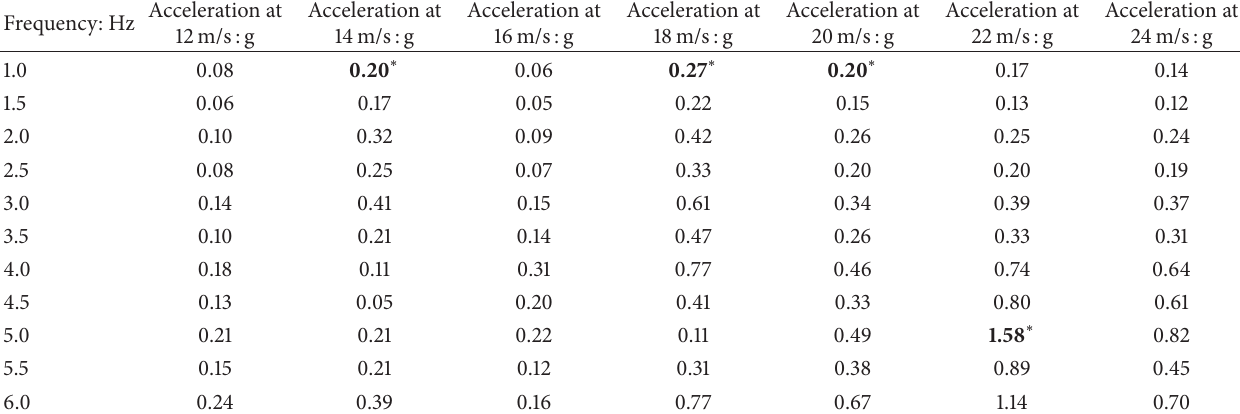
Table 4: Gust response alleviation result for varying frequencies and fixed